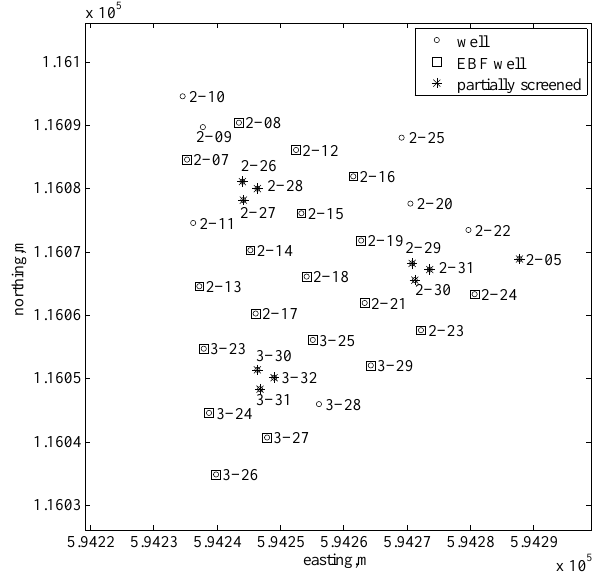
Fig. 1. Site map of the IFRC site (The coordinate system follows the convention used at the Hanford